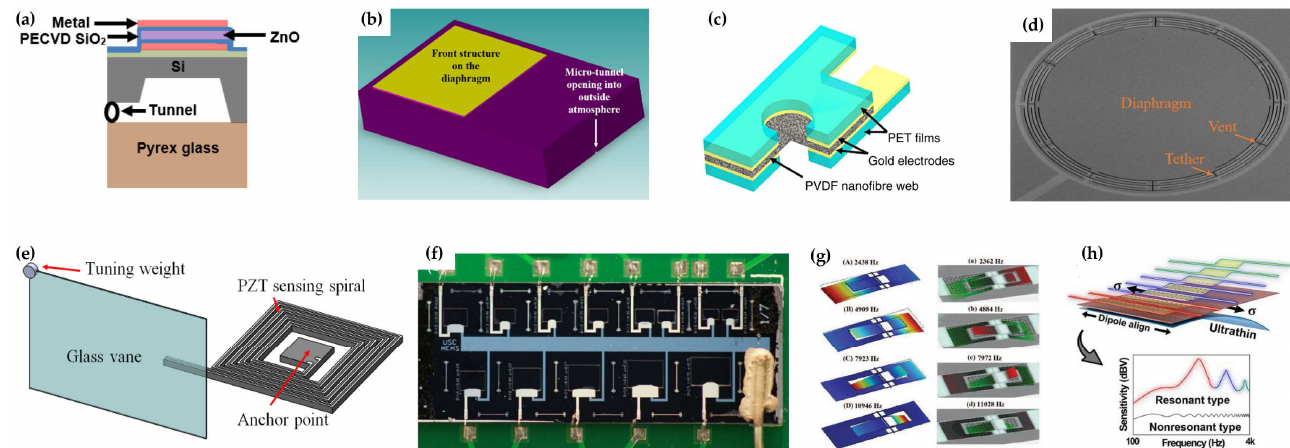
Figure 2. Piezoelectric MEMS microphones. ( a ) Microphone with a ZnO film and a micro-tunnel structure from Prasad et al. [18]. ( b ) High SPL microphone from Ali et al. [19]. ( c ) Microphone based on piezoelectric nanofibers from Lang et al. [20]. ( d ) 430 Hz to 10 kHz resonant microphone from Reger et al. [21]. ( e ) 12.6 V/Pa sensitivity resonant microphone from Pinrod et al. [22]. ( f ) Multi-resonance microphone array from Baumgartel et al. [23]. ( g ) Single structure multi-resonance microphone from Zhang et al. [24]. ( h ) multi-resonance flexible microphone from Wang et al. [25].